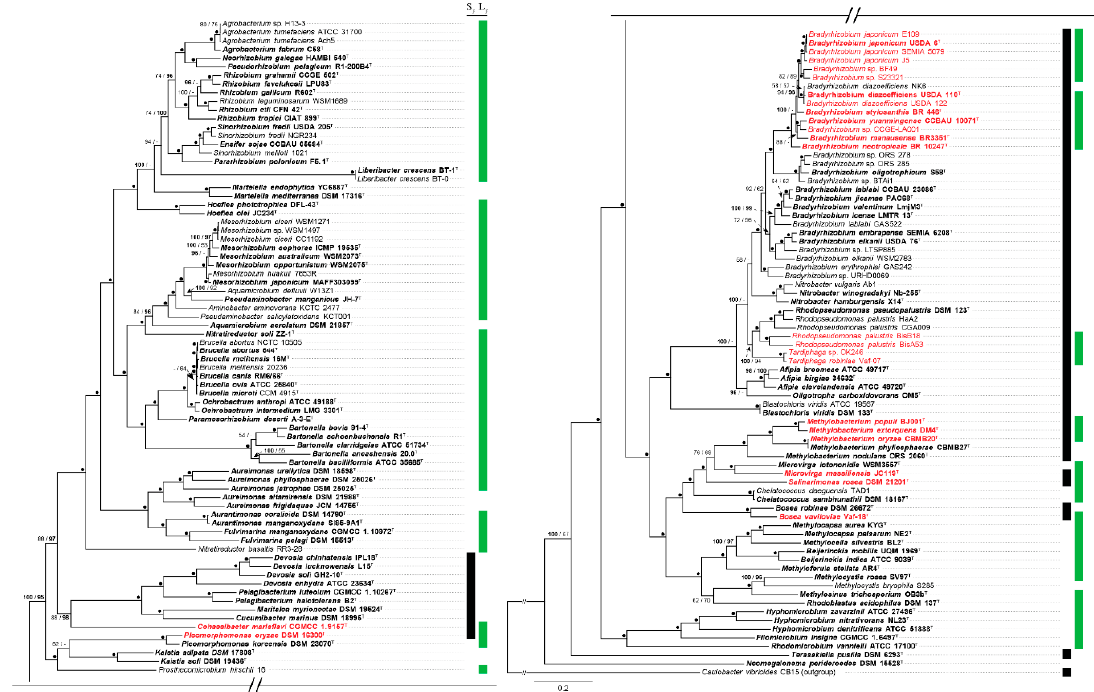
Figure 4. ML tree inferred from 104 concatenated single-copy amino acid sequences of 150 representative Rhizobiales genomes. Caulobacter vibrioides CB15 was used as outgroup. Bootstrap values under ML and MP tree searches are indicated above branches, left and right respectively. Dots indicate maximum support under all settings and values above 95% are shown in bold. Subpolar flagellum (S F , black), lateral flagellum (L F , green). Bold and T indicate type strain. Red typing indicates genomes with both flagellar systems. For additional information, see Supplementary Data S3.